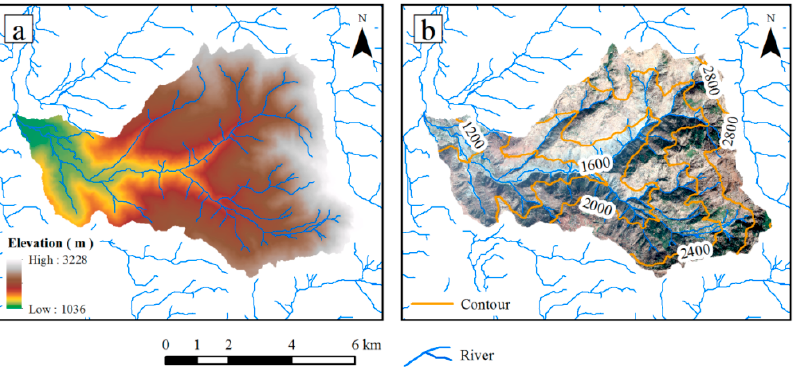
Figure 2. Data of the JJG. ( a ) DEM data of the JJG; ( b ) High-resolution remote sensing image of the JJG.